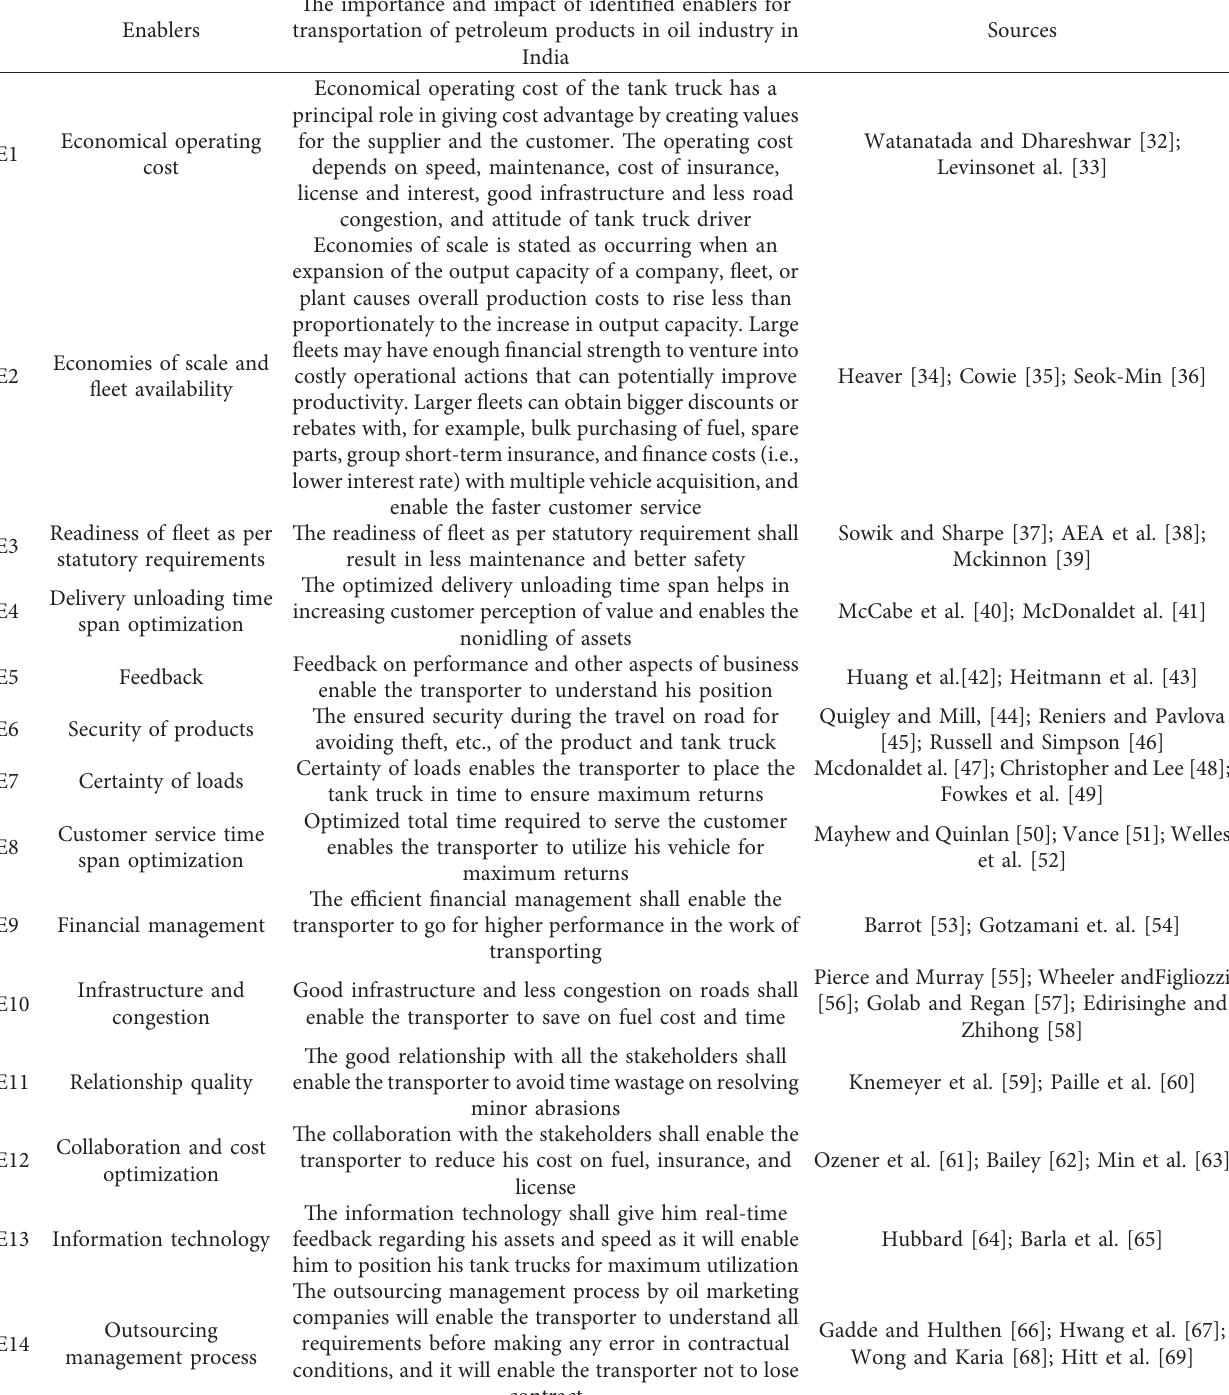
Table 2: Enablers to transporters’ performance in oil